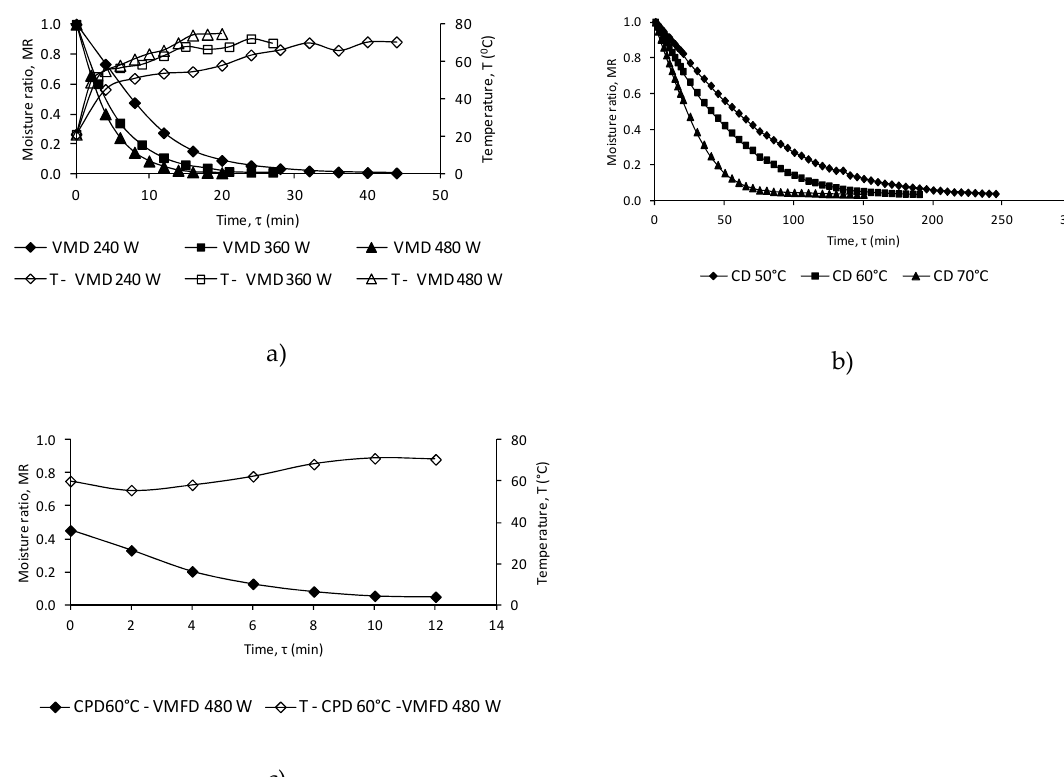
Figure 1. (a) Drying kinetics of true lavender flower samples processed using vacuum microwave drying vacuum-microwave drying (VMD) at powers of 240, 360 and 480 W. (b) Drying kinetics of true lavender flower samples processed using convective drying convective drying (CD) at temperatures of 50, 60 and 70 ◦ C. (c) Drying kinetics of true lavender flower samples processed using vacuum-microwave finish drying (VMFD) at 480 W after convective pre-drying (CPD) at a temperature of 60 ◦ C. Table 1. Final moisture content (M fwb ), maximum temperature of the sample T, convective drying time ( τ ), vacuum microwave drying time ( τ 1 ), and constants A, k and n of the modified Page model describing the drying kinetics.